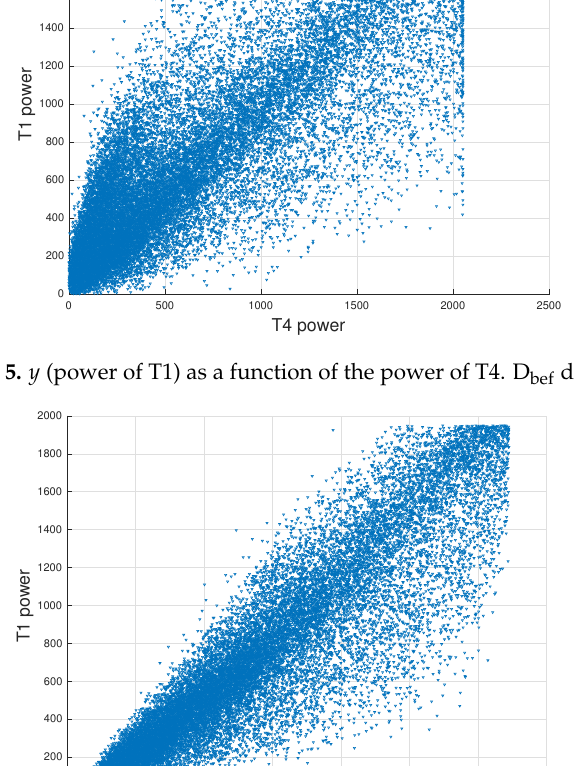
Figure 6. y (power of T1) as a function of the first principal component of the covariatives matrix. D bef data set.